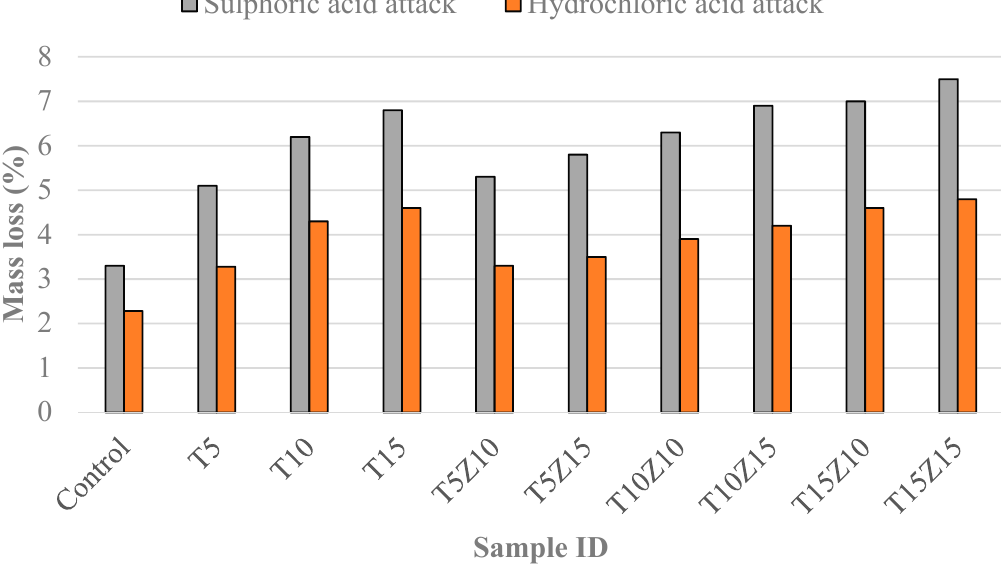
Figure 9. Mass loss by sulphuric and hydrochloric acid attack of specimens containing different percentages of zeolite and tuff.